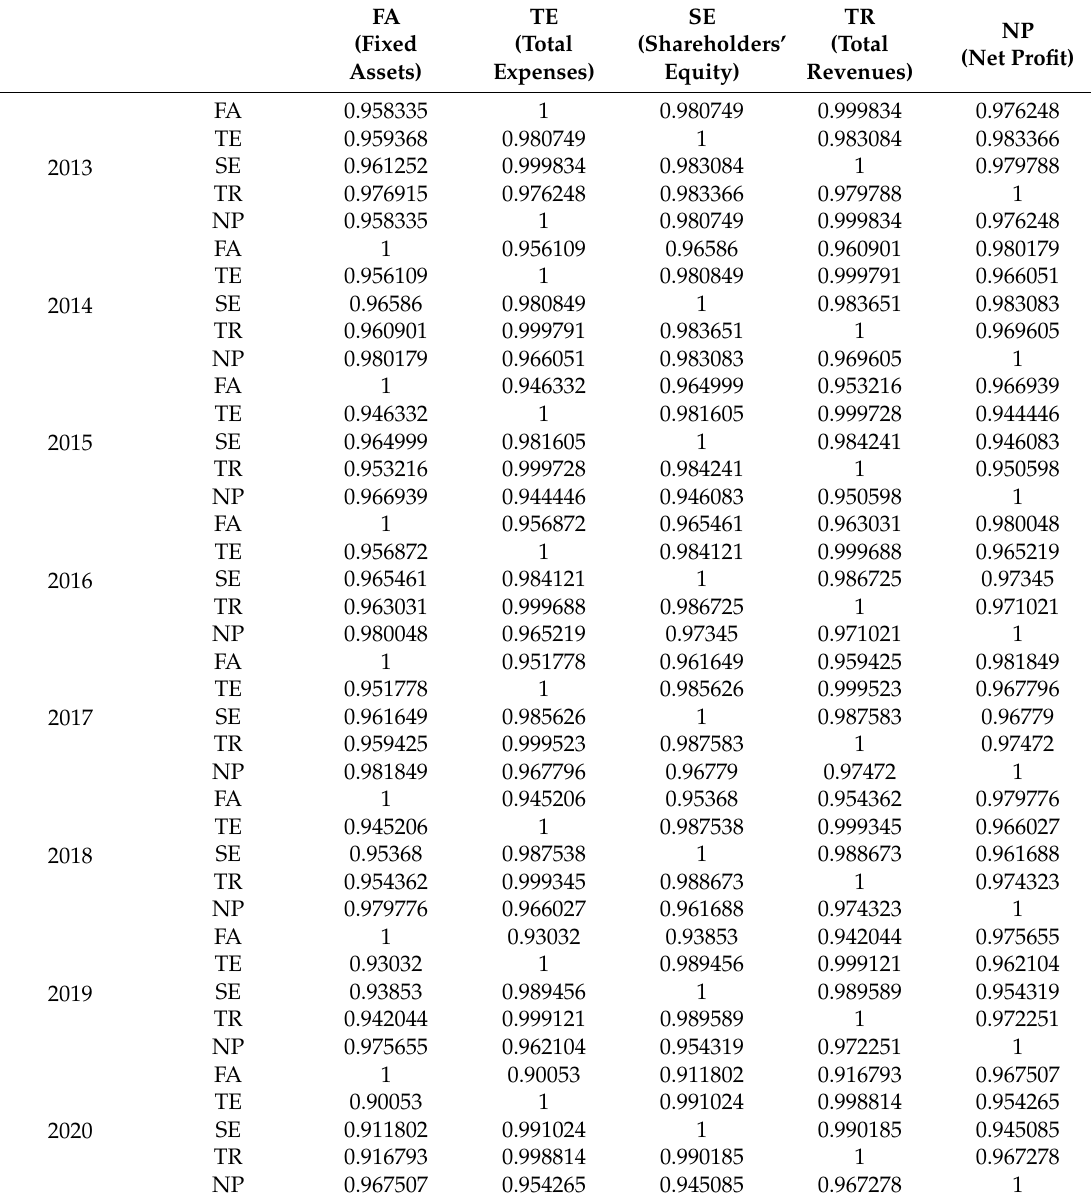
Table 5. Correlation coefficients in